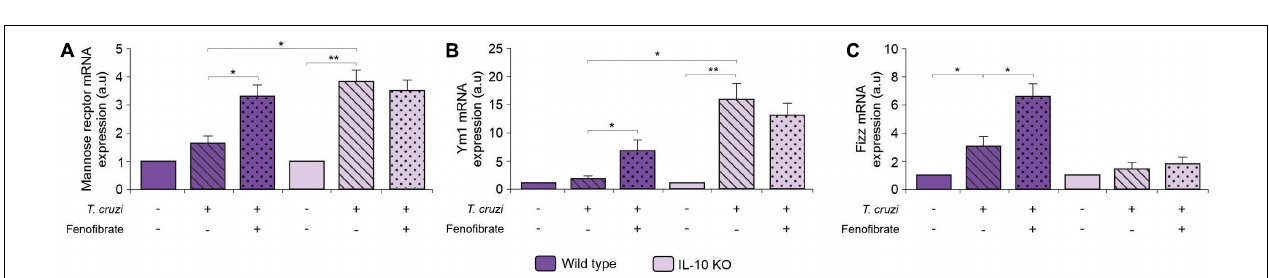
FIGURE 8 | Relationship between cardiac disfunction and IL-6. Spearman rank-order correlation test between ejection fraction (A) or shortening fraction (B) and concentration of IL-6 in sera from uninfected, T. cruzi -infected, and T. cruzi -infected and fenofibrate-treated WT and IL-10 KO mice were made. Spearman correlation coefficient is reported for each of the correlations.